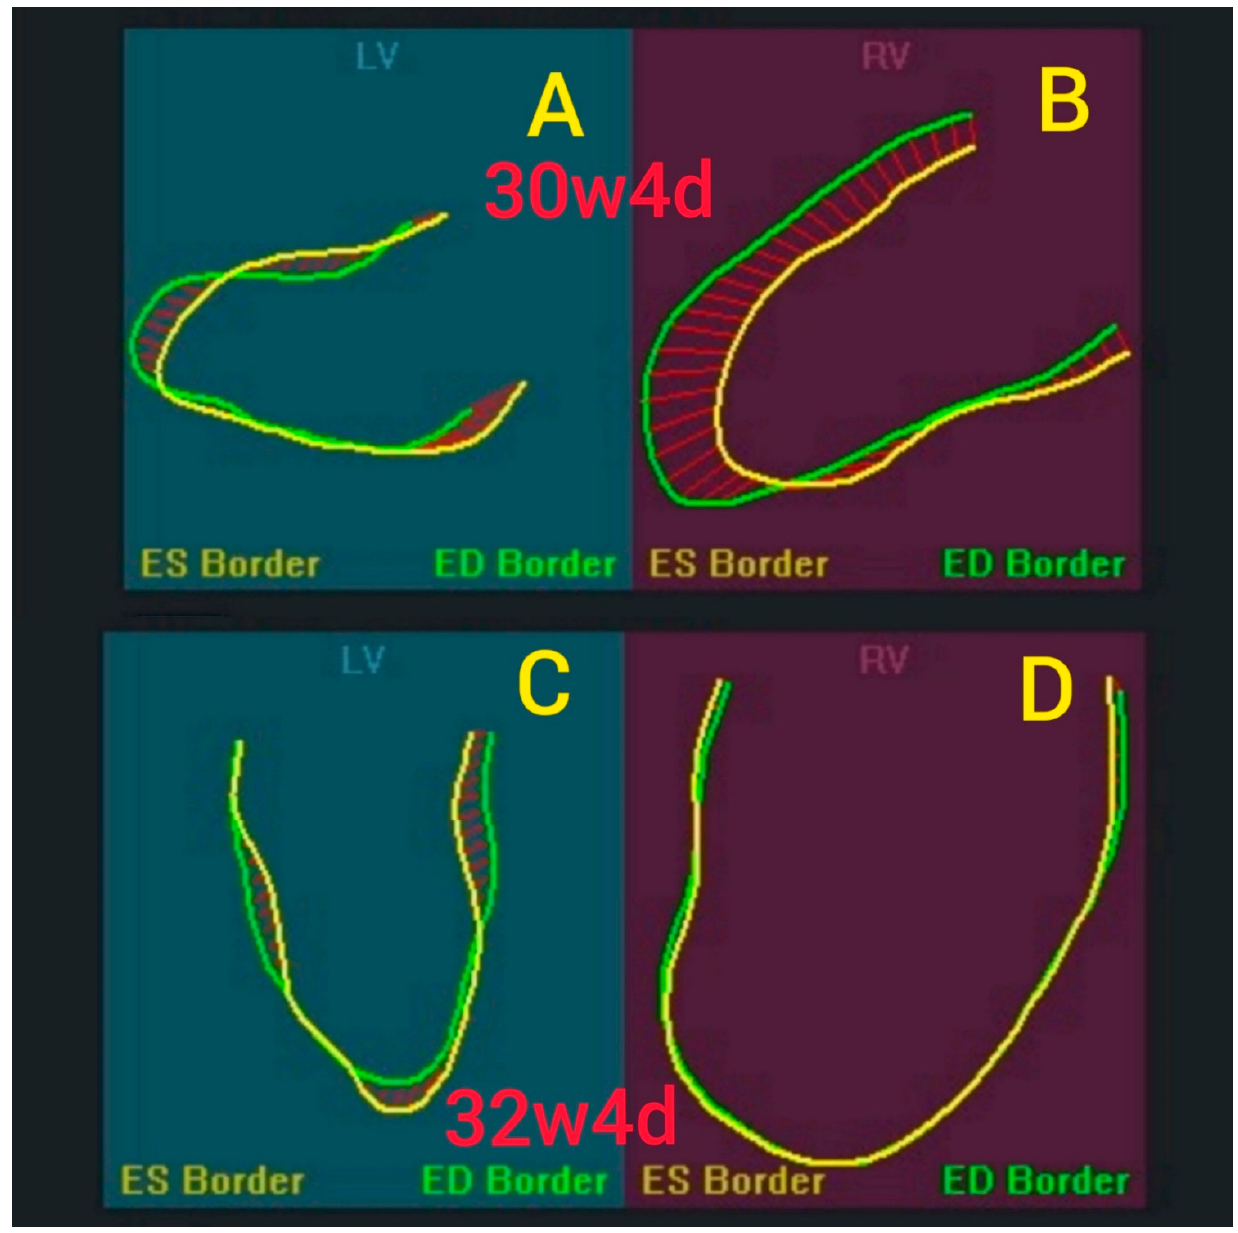
Figure 1. ( A , B ) Fetal strain at 30 weeks 4 days. ( C , D ) Fetal strain at 32 weeks 4 days. End-Systolic/End-Diastolic Borders of LV-left ventricle and RV-right ventricle